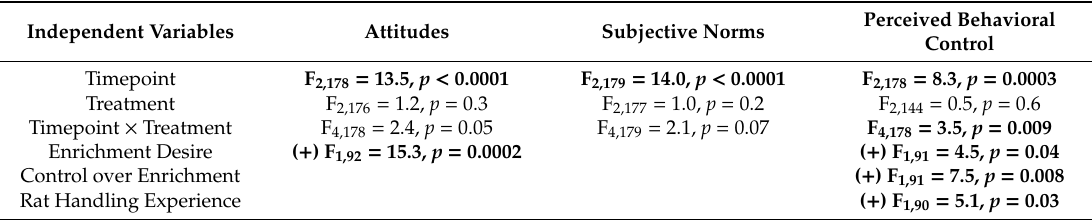
Table 4. Beliefs about rat tickling. The associations from general linear mixed models of self-reported data from laboratory animal personnel. Participants were asked about their attitudes, subjective norms, and perceived behavioral control with rat tickling.